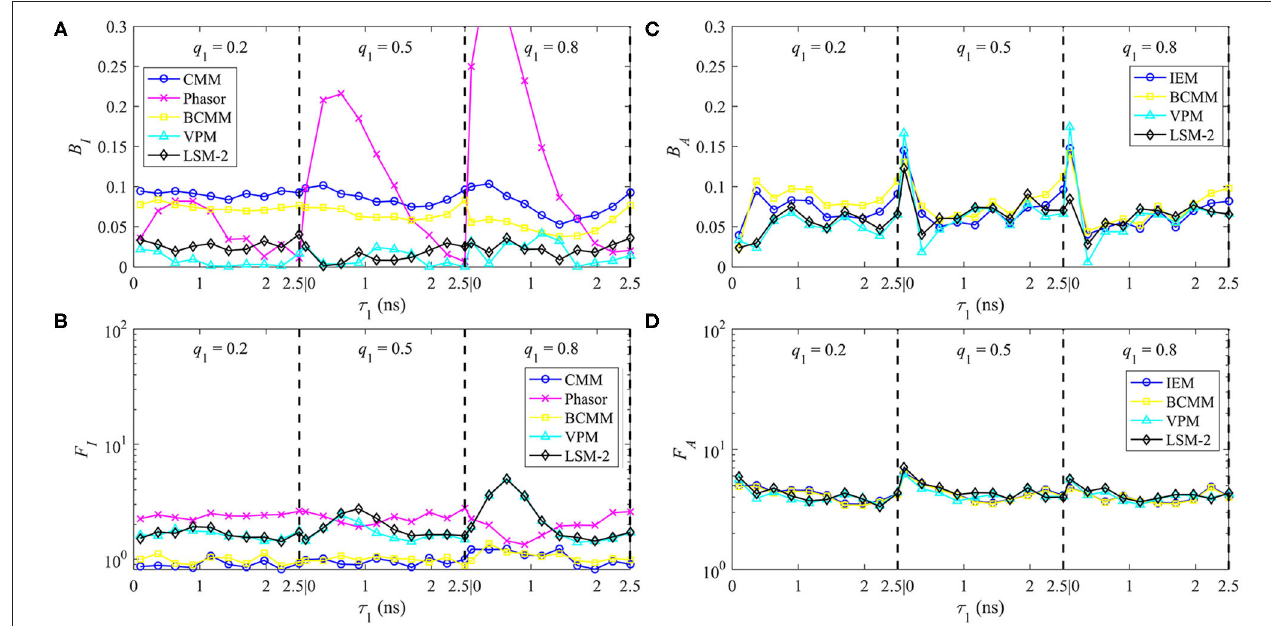
FIGURE 6 | The performances of τ I and τ A estimations with bi-exponential decay signals with τ 1 B A , (D) F A